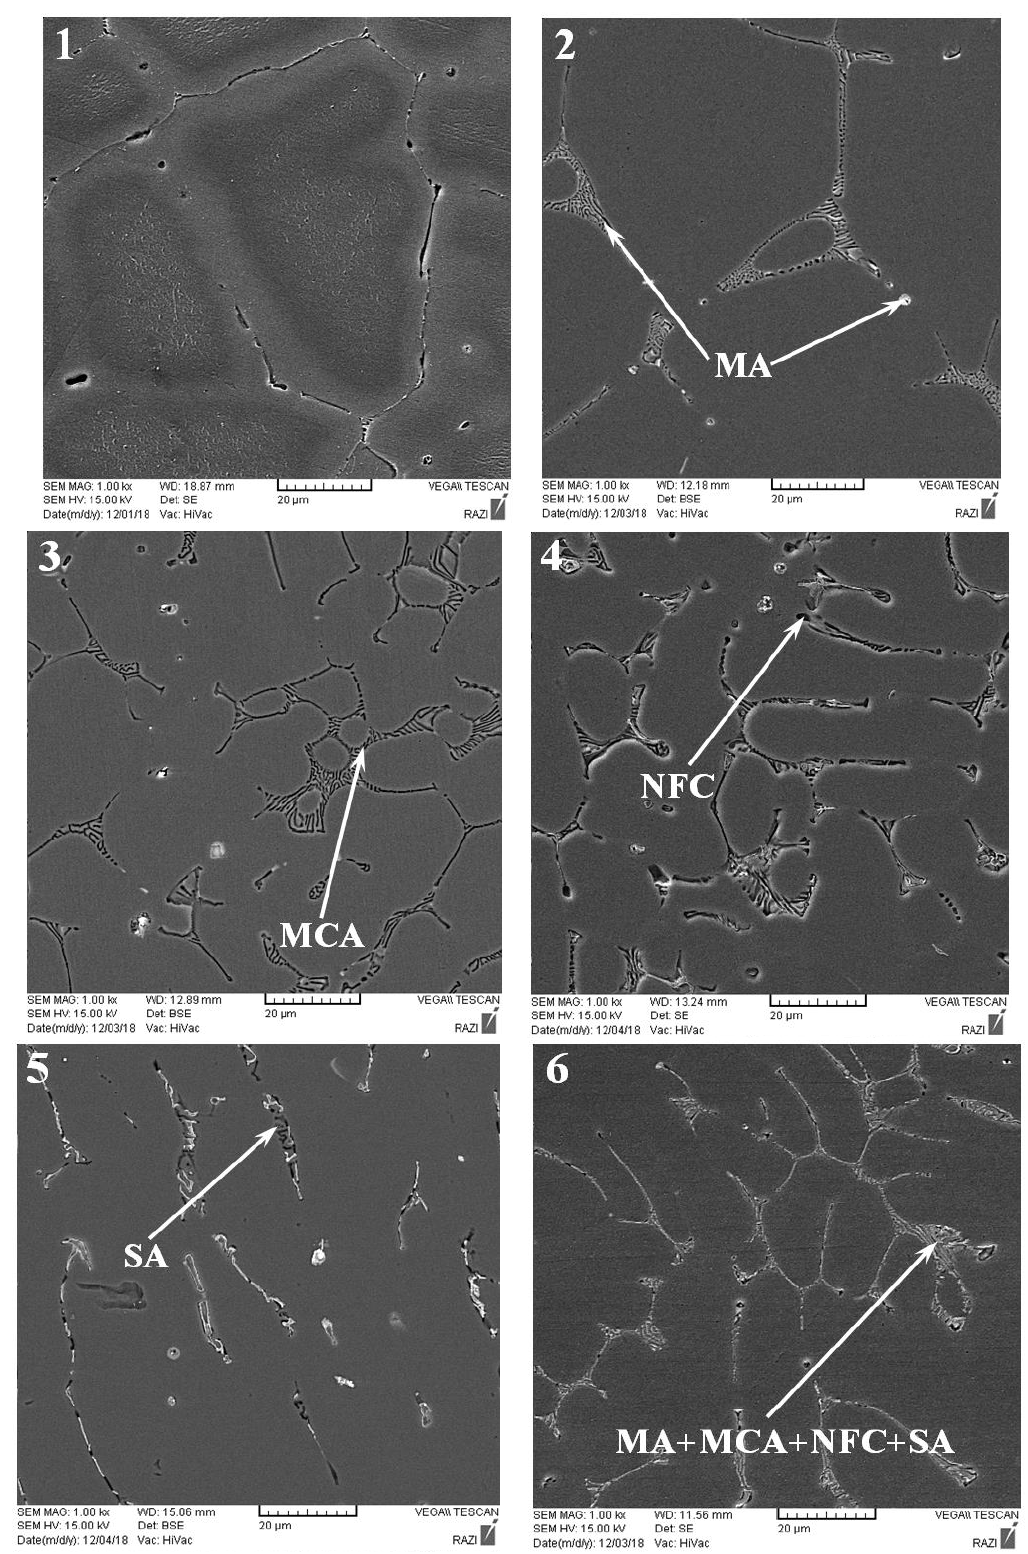
Figure 16: Represented photomicrography of scanning electron microscope of all test